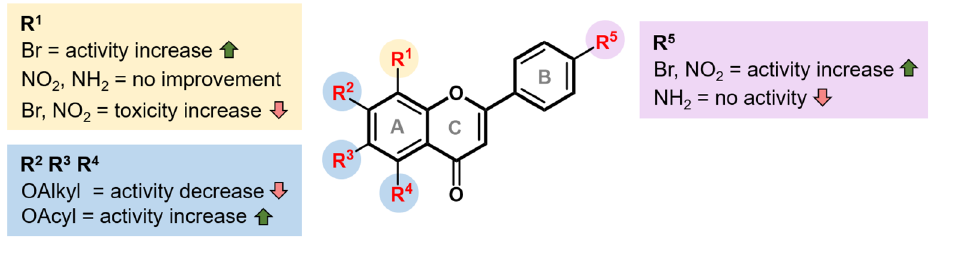
Figure 4. The SAR